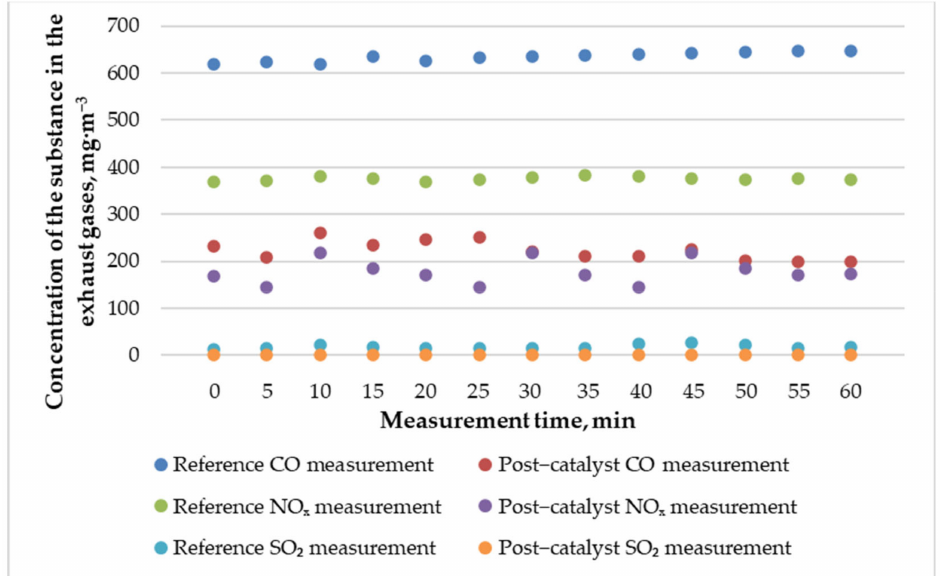
Figure 4. Comparison of the concentration of pollutants in exhaust gases without and with the use of a